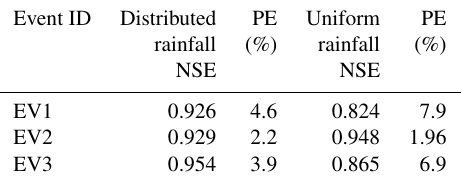
Table 5. The NSE coefficients and PE values of baseline scenario under the three distributed rainfall events and three uniform rainfall